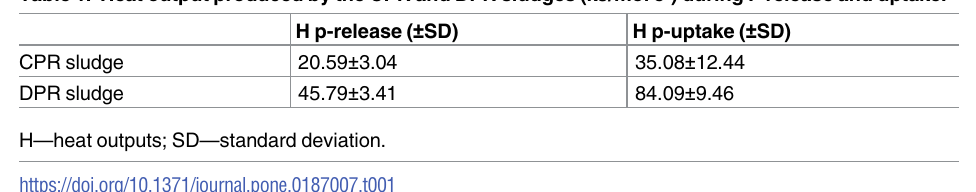
Table 1. Heat output produced by the CPR and DPR sludges (kJ/mol e-) during P release and uptake.